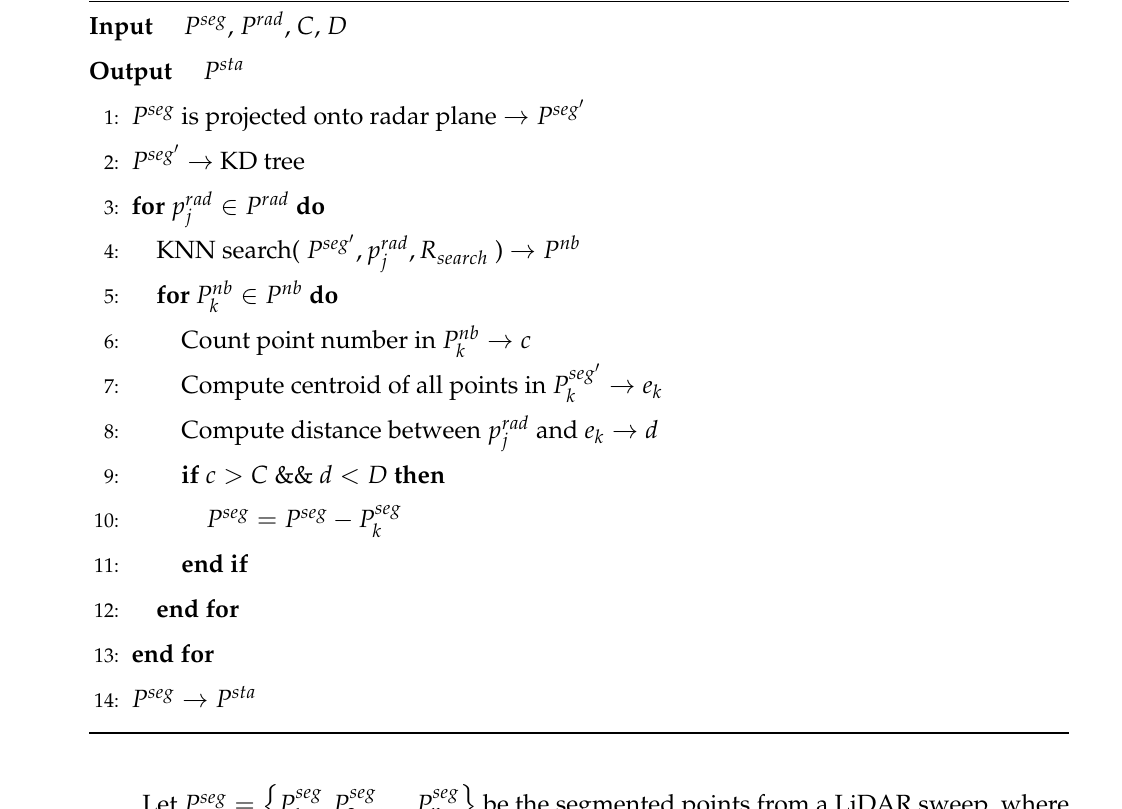
Algorithm 1 Data